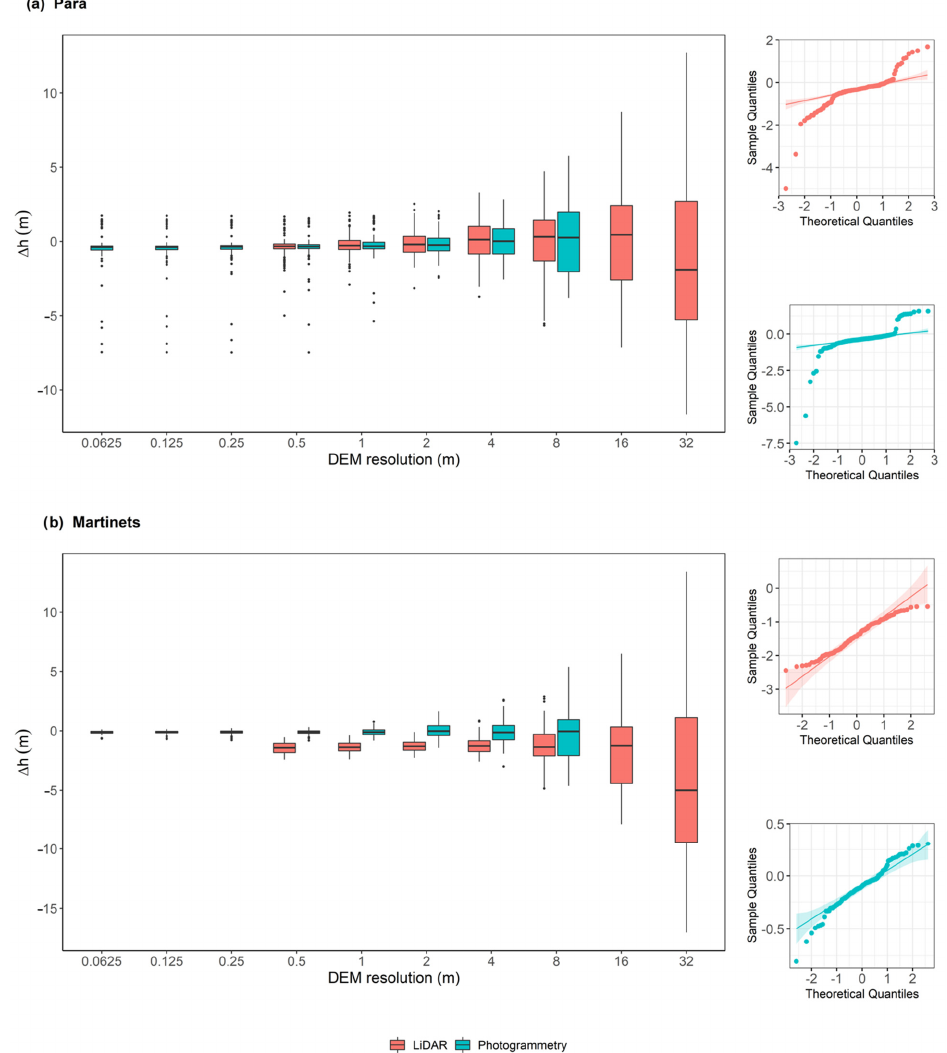
Figure 3. The vertical error ( ∆ h; in meters) of DEMs acquired from LiDAR (orange) or PHOTO (blue) technologies across all resolutions for ( a ) Para (n = 157) and ( b ) Martinets (n = 110). Boxplots are accompanied by examples of Q–Q plots of LiDAR and PHOTO DEM errors at 0.5m resolution. The complete set of Q–Q plots for both sites can be found in Figure S1.